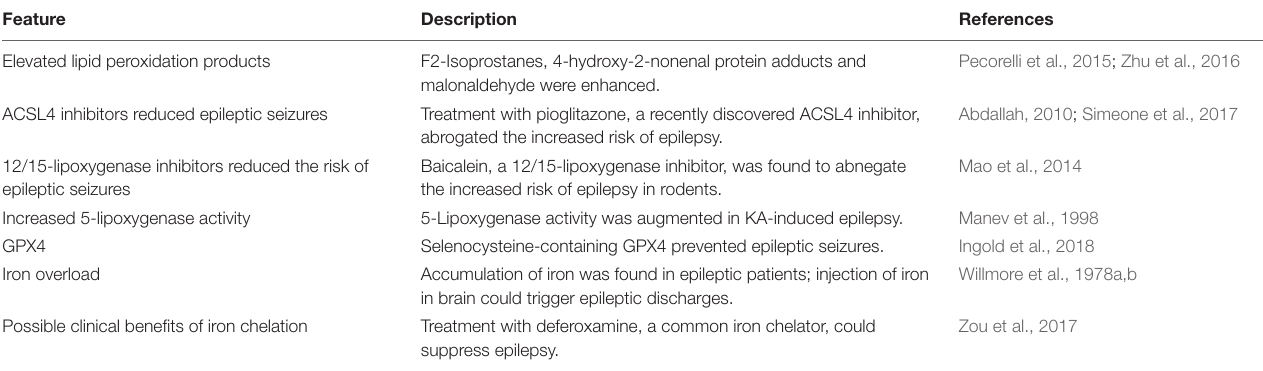
TABLE 1 | Features of epilepsy consistent with